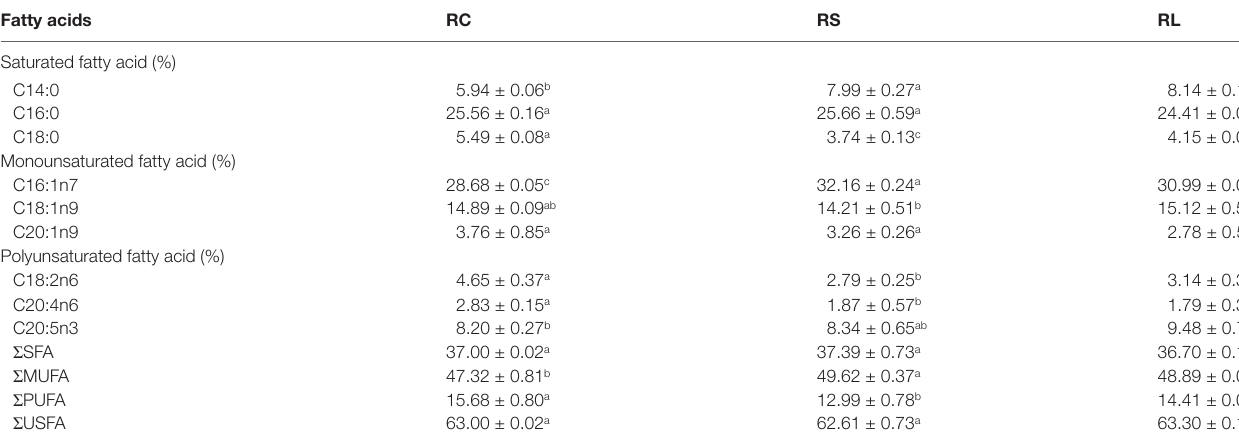
TABLE 6 | Fatty acid composition (%) of B. plicatilis under different treatments (RC, RS and RL). Fatty acids RC Saturated fatty acid (%)